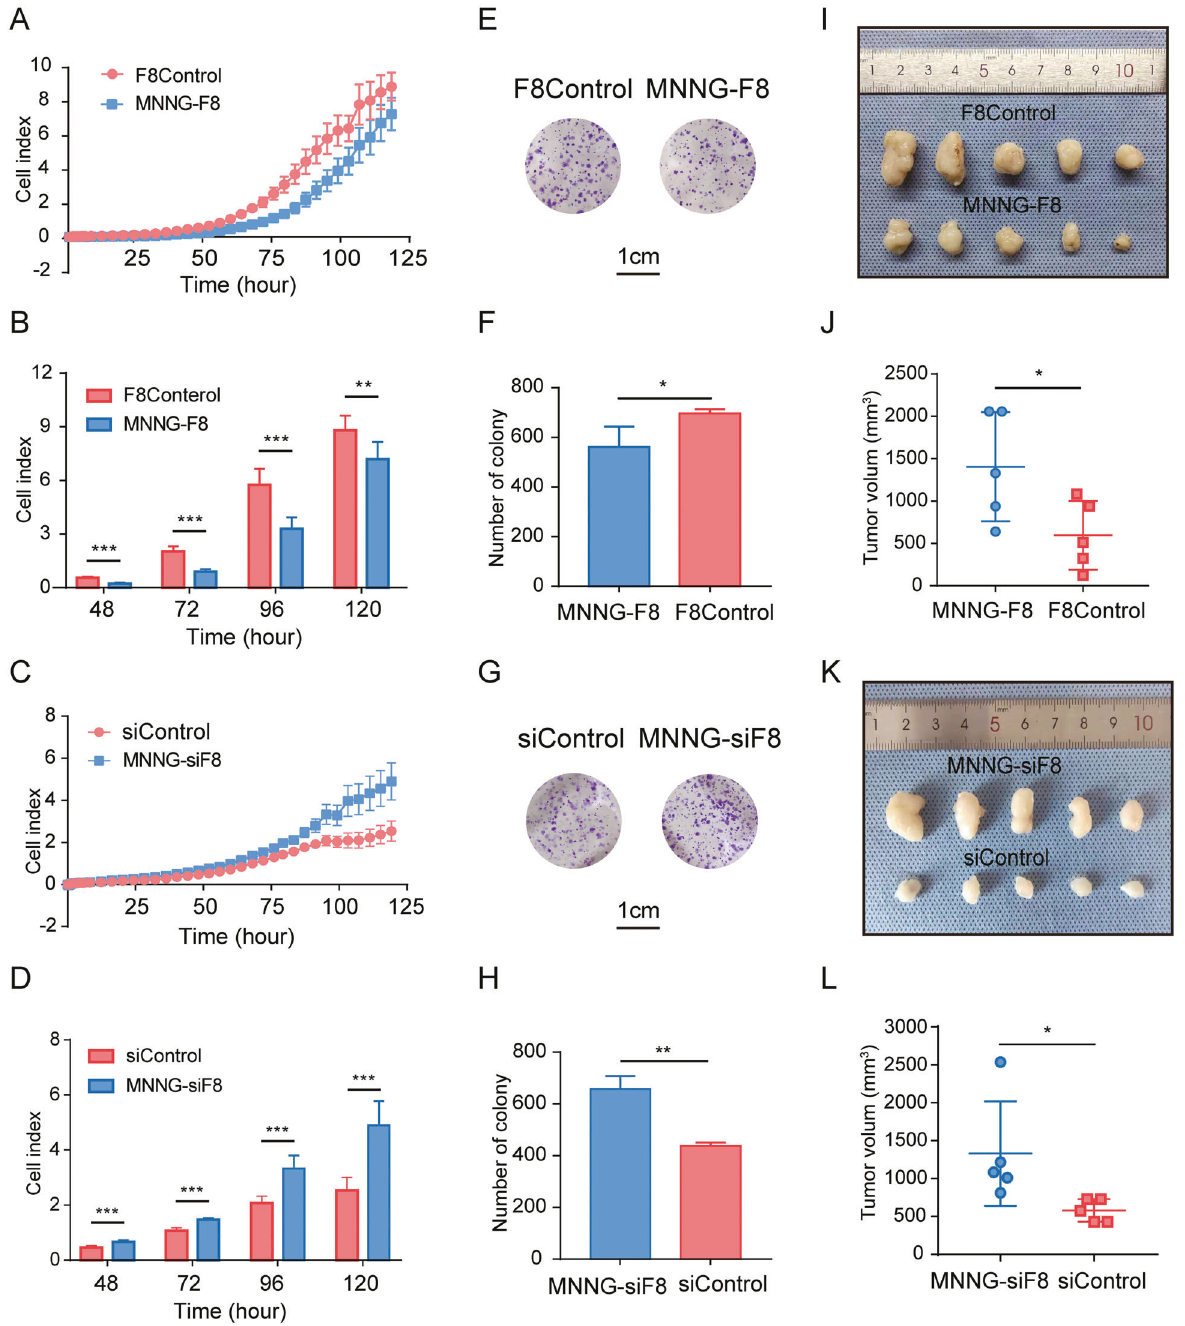
Fig. 2 FUT8 expression is negatively correlated with OS oncogenesis in vitro and in vivo. A , C Mean ± SD ( N = 4) cell index, a measure of cell attachment and cell proliferation in vitro, for two FUT8-regulated OS cell lines (MNNG-F8, MNNG-siF8) and their control cell lines (F8Control, siControl, respectively) over time. RTCA assay con fi rmed that cell proliferation is enhanced in vitro in MNNG-siF8 cells, while it is reduced in MNNG-F8 cells compared to control cells. B , D Mean ± SD ( N = 4) cell index at 48 h, 72 h, 96 h, 120 h. E , G Representative light microscopic images of PFA- fi xed MNNG-F8, MNNG-siF8, and control cells stained with crystal violet, and ( F, H ) quantitation of colony counts after 2 weeks of in vitro maintenance, data were shown as mean ± SD ( N = 3). I , K Images of excised fl ank tumors after injecting 200 μ l of cell suspension from MNNG-F8 ( N = 5), MNNG-siF8 ( N = 5), or control cells ( N = 5) in the nude mouse subcutaneous tumor model, and ( J , L ) quantitation of tumor volume (mean ± SD). * P < 0.05; ** P < 0.01; *** P <